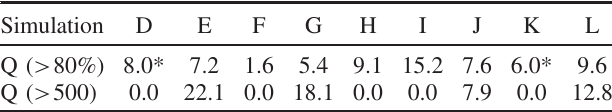
TABLE II. List of charge accelerated within the highest 20% c for different simulations. All of momentum and above 500 m e values are in pC. The asterisk indicates that the value was calculated from an earlier time step in simulations D and K compared to all other simulations due to dephasing and charge reduction of electrons at later time